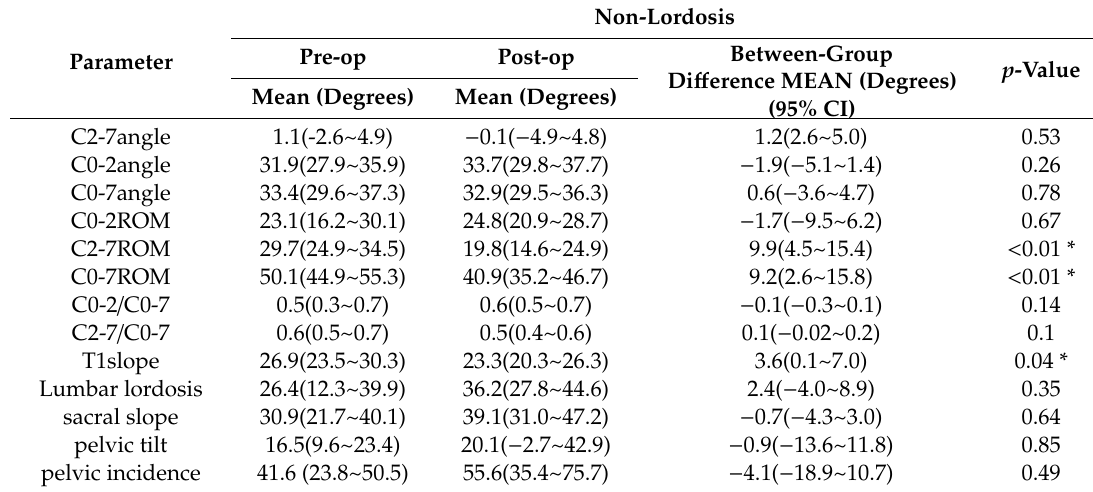
Table6. Comparisonof pre-operativevs. post-operativeradiological parametersof non-lordosis groups.